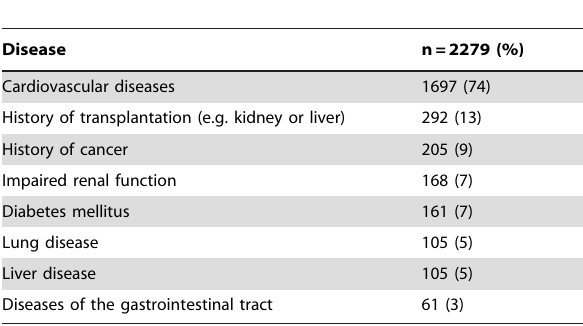
Table 2. Diseases declared by users (multiple entries possible).